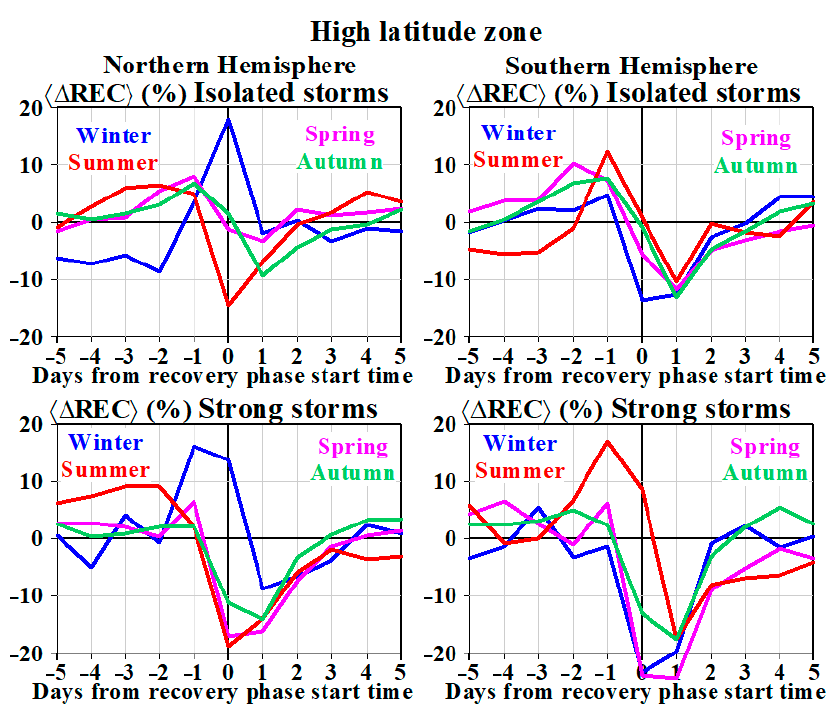
Figure 3. The same as Figure 2 but for high-latitude